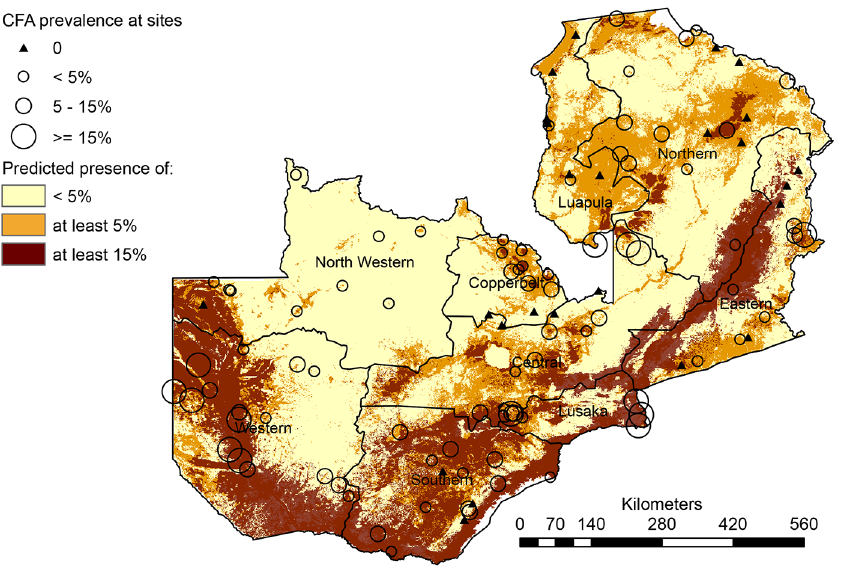
Figure 4. Map resulting from the overlay of the thresholded versions of the maps in Figure 4. The map depicts areas of predicted presence of $ 15% CFA prevalence (brown), $ 5% CFA prevalence (orange + brown) and areas where no or , 5% CFA is predicted to be present (light yellow).